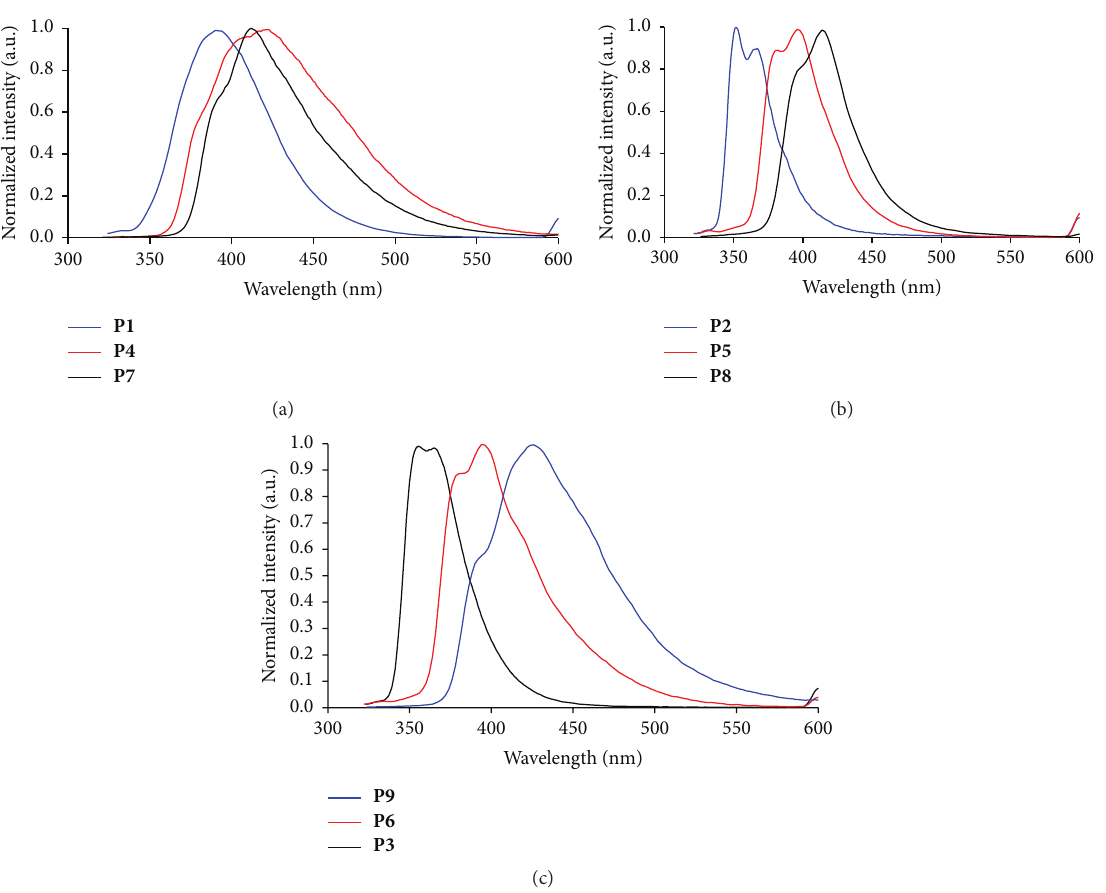
Figure 4: Emission spectra of (a) P1 , P4 , and P7 ; (b) P2 , P5 , and P8; and (c) P3 , P6 , and P9 recorded in DMF at 30 ∘ C.